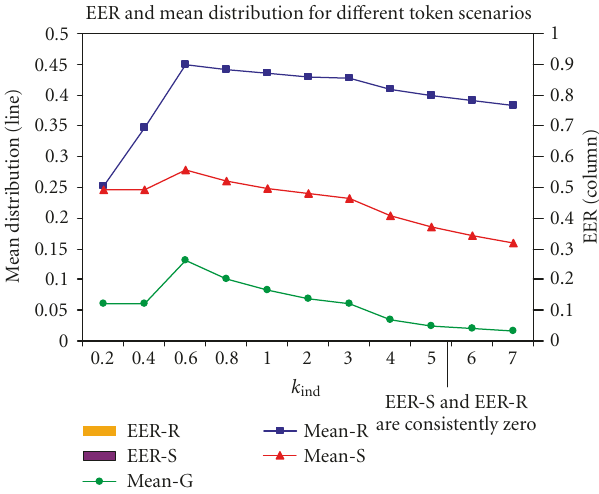
Figure 3: EER and mean distribution for genuine token scenario.